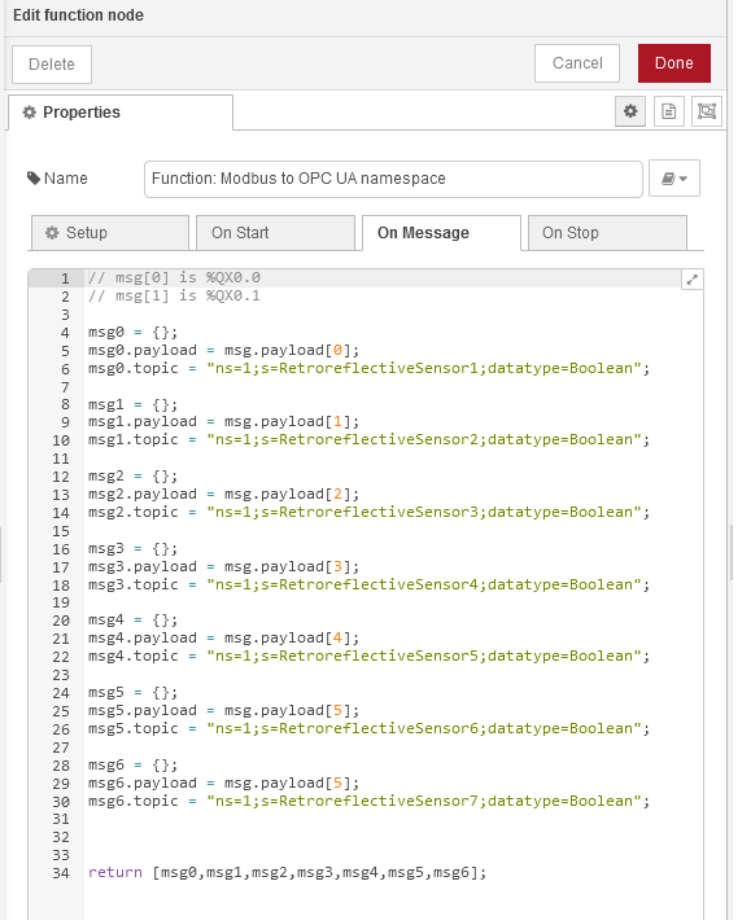
Figure 13. Function for filling OPC UA server with values obtained using Modbus protocol from OpenPLC— Function: Modbus to OPC UA